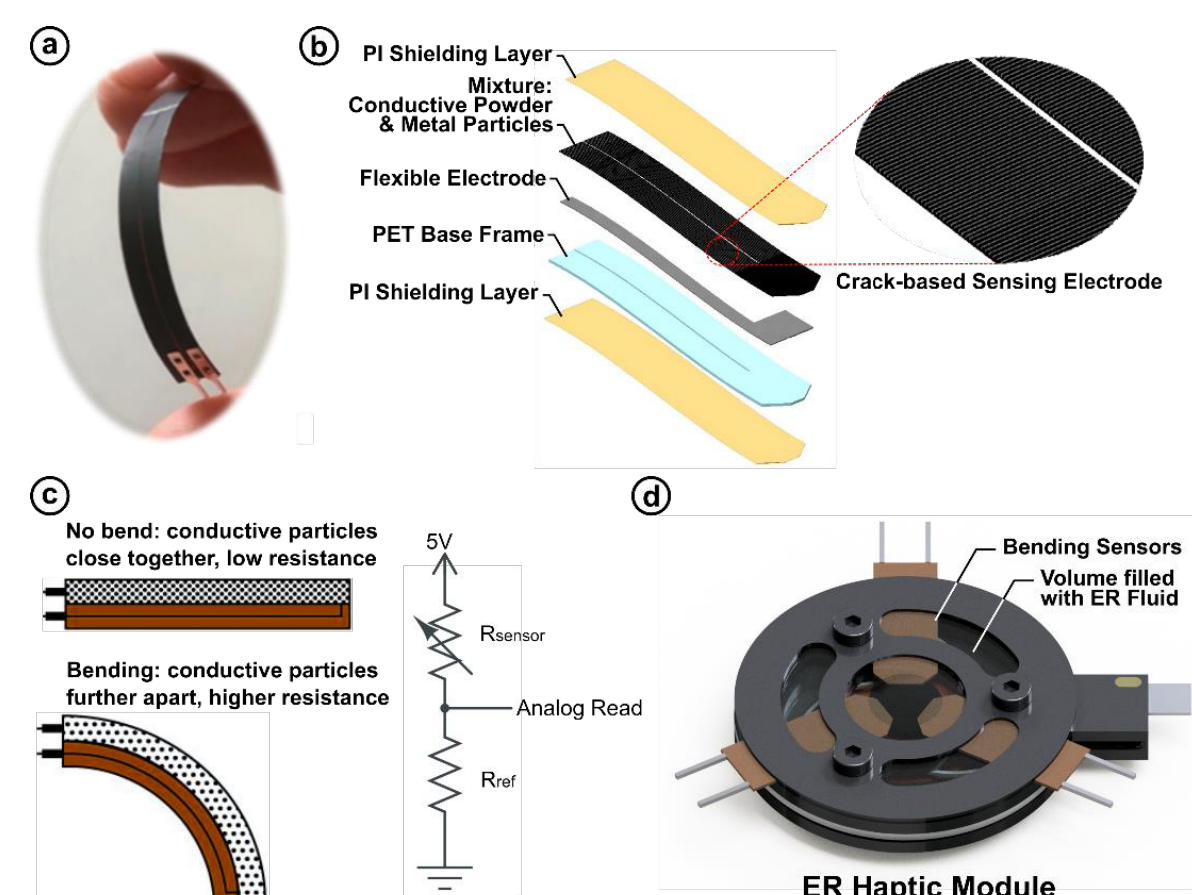
Figure 3. ( a ) Proposed bending sensor; ( b ) bending sensor construction; ( c ) sensor working principle and circuit diagram; ( d ) haptic module with ER actuator and bending sensor. To visualize the actuator’s internal components, the ER fluid that fills its volume is rendered as transparent.